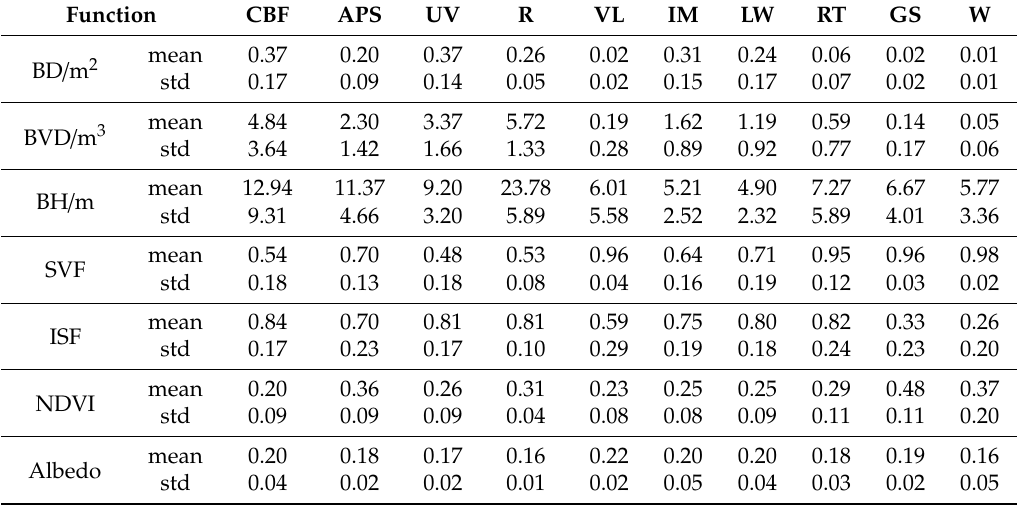
Table 3. Indicators statistics in di ff erent UFZs.